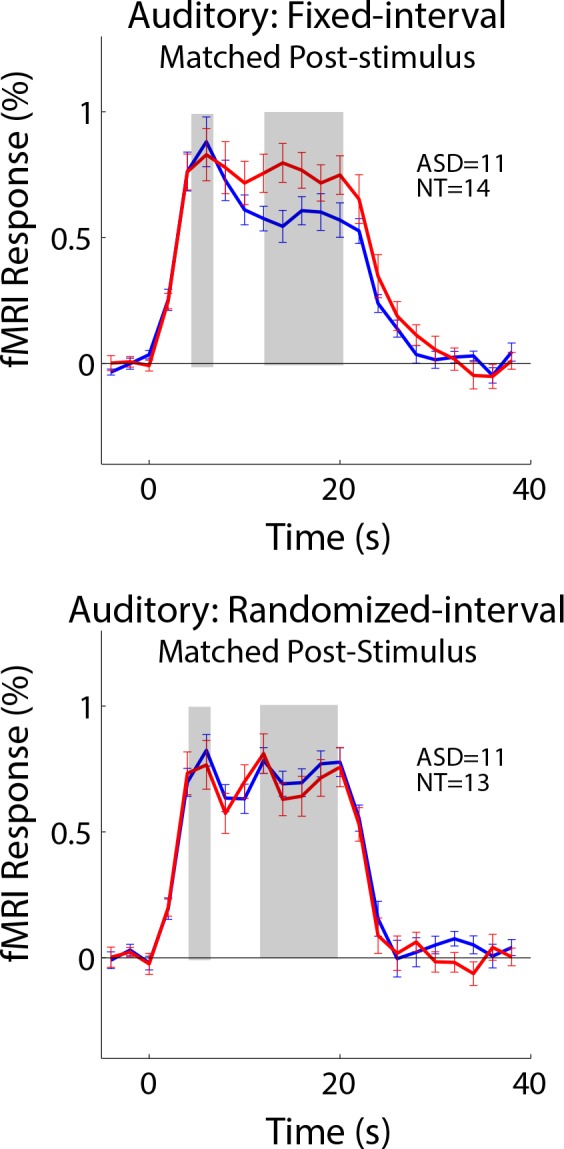
Subgroups were formed that were equated for the post-stimulus response.Differences in the sustained response remained in the fixed-interval condition (top).10.7554/eLife.36493.009Figure 4—source data 1.FMRI timecourses in auditory cortex after matching for post-stimulus response.